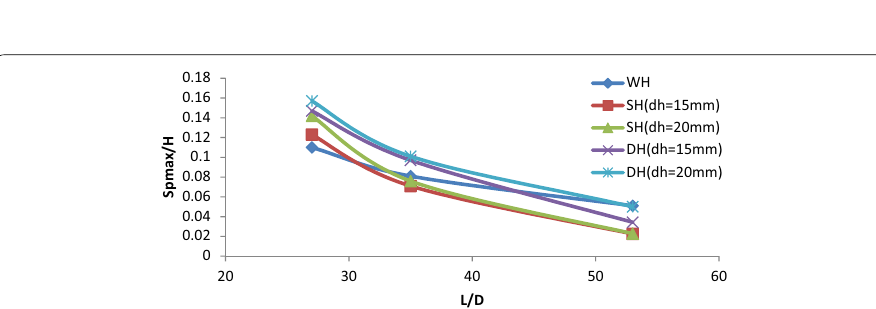
Fig. 11 Variation of ratio (Spmax/H) with (L/D) ratio of helical pile with different lengths and helix